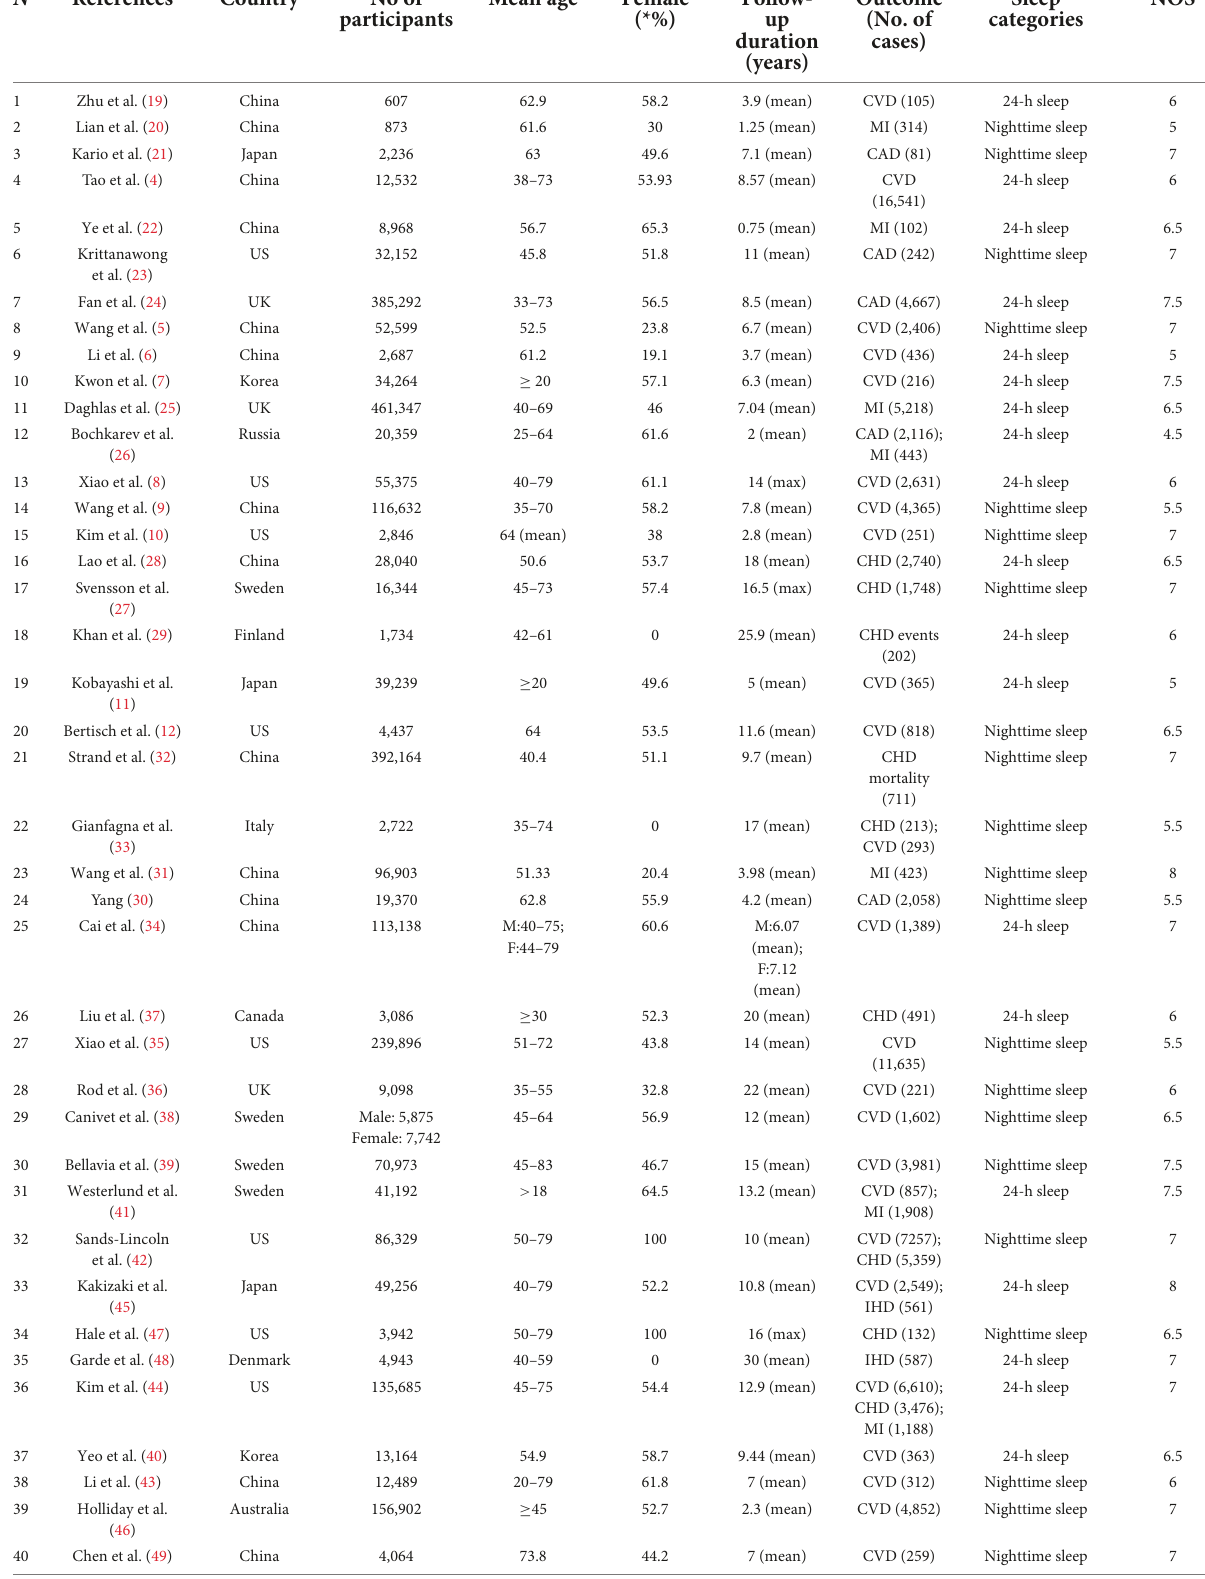
TABLE 1 Characteristics of 57 studies about cardiovascular diseases included in the